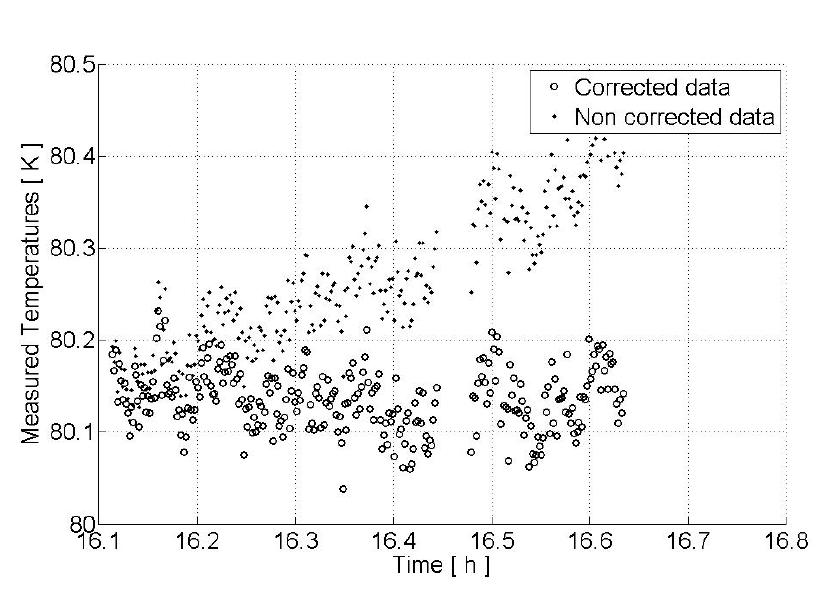
Figure 5. Stability of the CAROLS measurements. Non corrected data correspond to one calibration point; corrected data correspond to two calibration points before and after data